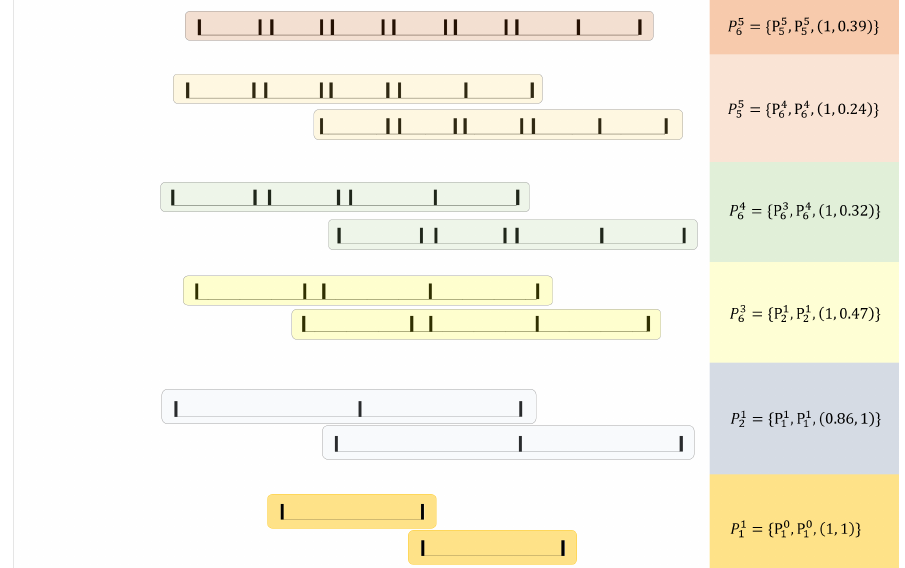
Figure 10. The structure of part P 6 . All subpart compositions were formed from two instances of a 5 single part on layers {L 0 . . . L 5 } . The compositions’ parameters are shown on the right side. Each part is shown twice with the offset used in the consecutive layer’s